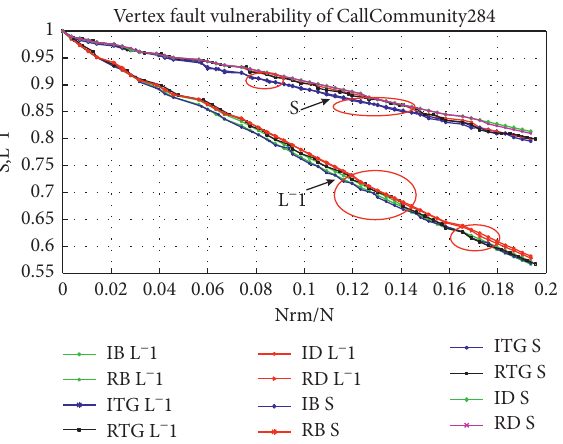
Figure 5: l − 1 & S result of CallCommunity.